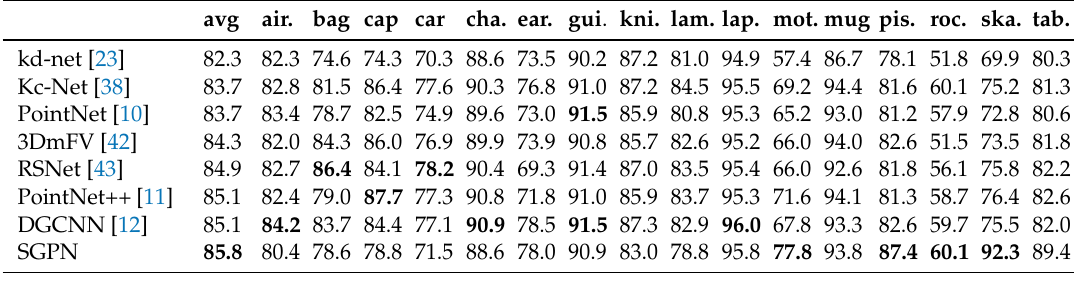
Table 4. Semantic part segmentation results on ShapeNet part dataset.